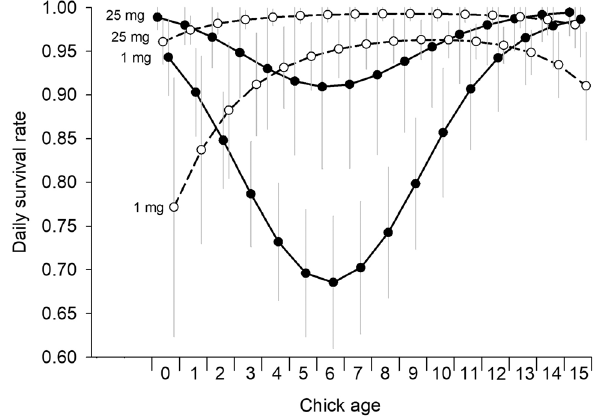
Figure 4. Estimated daily survival rates (± SD) of Dunlin chicks near Utqiaġvik, Alaska, 2008–2009 as a function of chick age for average hatch date for initial (3 July, dashed lines and open circles) and replacement (15 July, solid lines and closed circles) nests, and invertebrate biomass (1 and 25 mg/trap/day). Daily survival rates and associated SDs were estimated using 10,000 simulations of the beta estimates assuming a multivariate normal distribution and the variance–covariance matrix from the top-ranked model (HD*A 2 + I; where HD = hatch date, A = chick age, and I = daily invertebrate biomass; Table 1). Symbol locations represent the same chick age for each combination of hatch date and invertebrate abundance, but symbols are offset so SDs are visible.